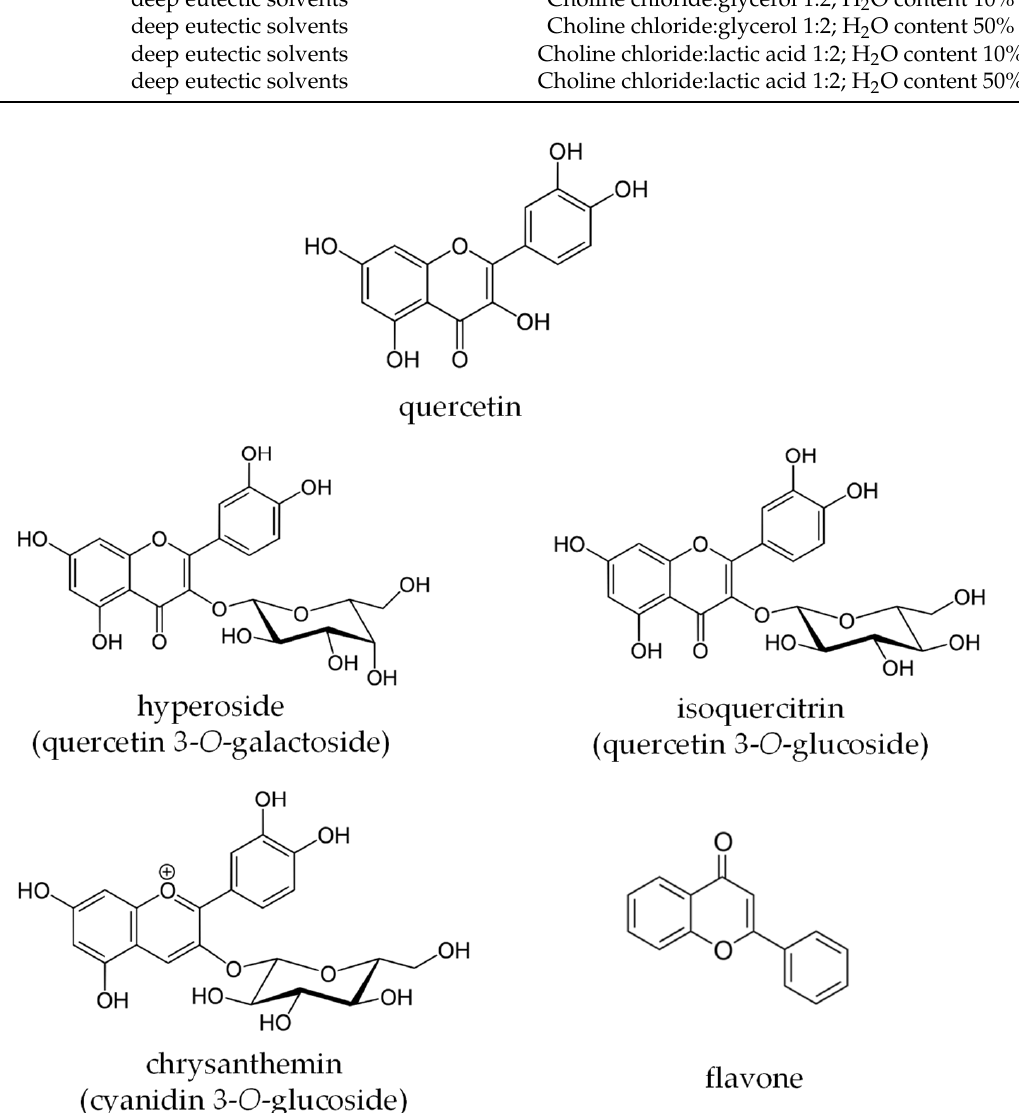
Figure 1. Targeted flavonoid compounds that were investigated in the feijoa flowers’ green extracts. Table 1. Feijoa fl ower samples and parameters of the green extraction techniques used.